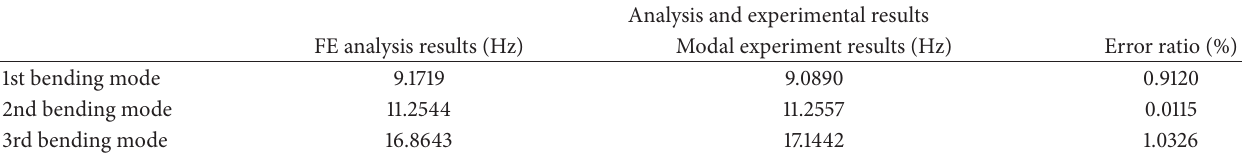
Table 5: Comparison of analysis and experimental frequency.